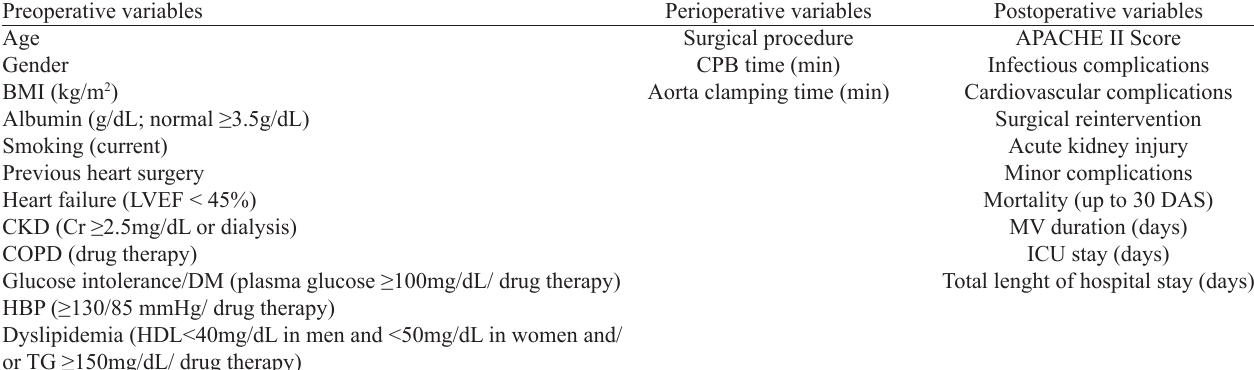
Table 1. Clinical variables in the